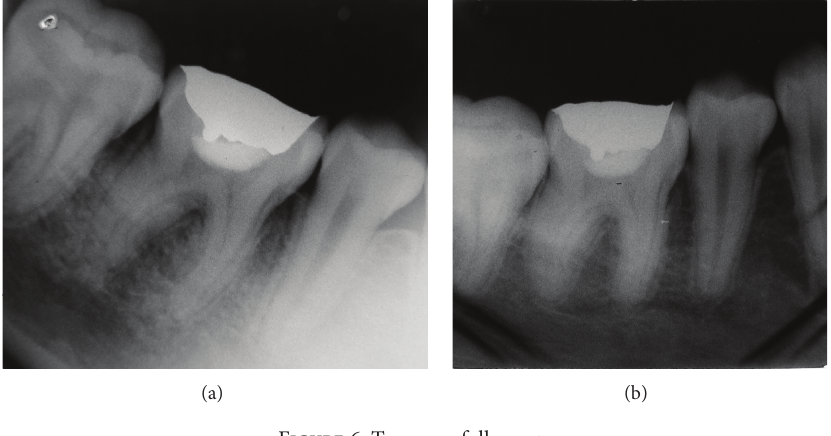
Figure 6: Two-year